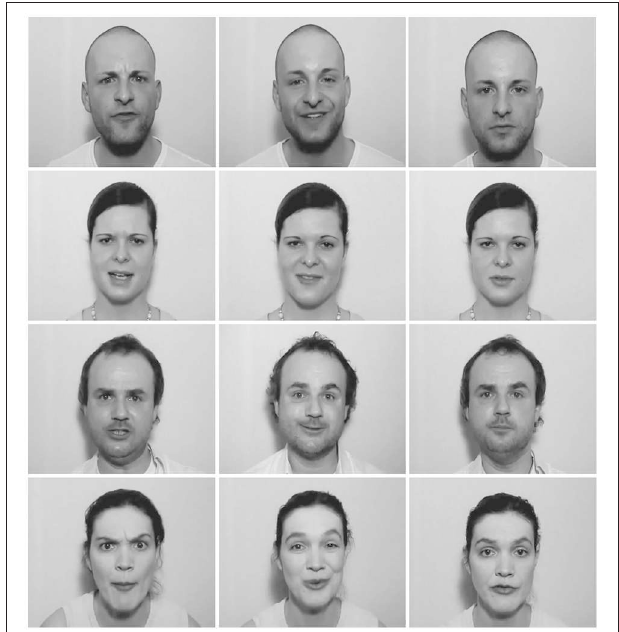
FIGURE 1 | Still example frames from the video primes, displaying angry (left), happy (middle), or neutral (right) facial expressions, one actor per line.